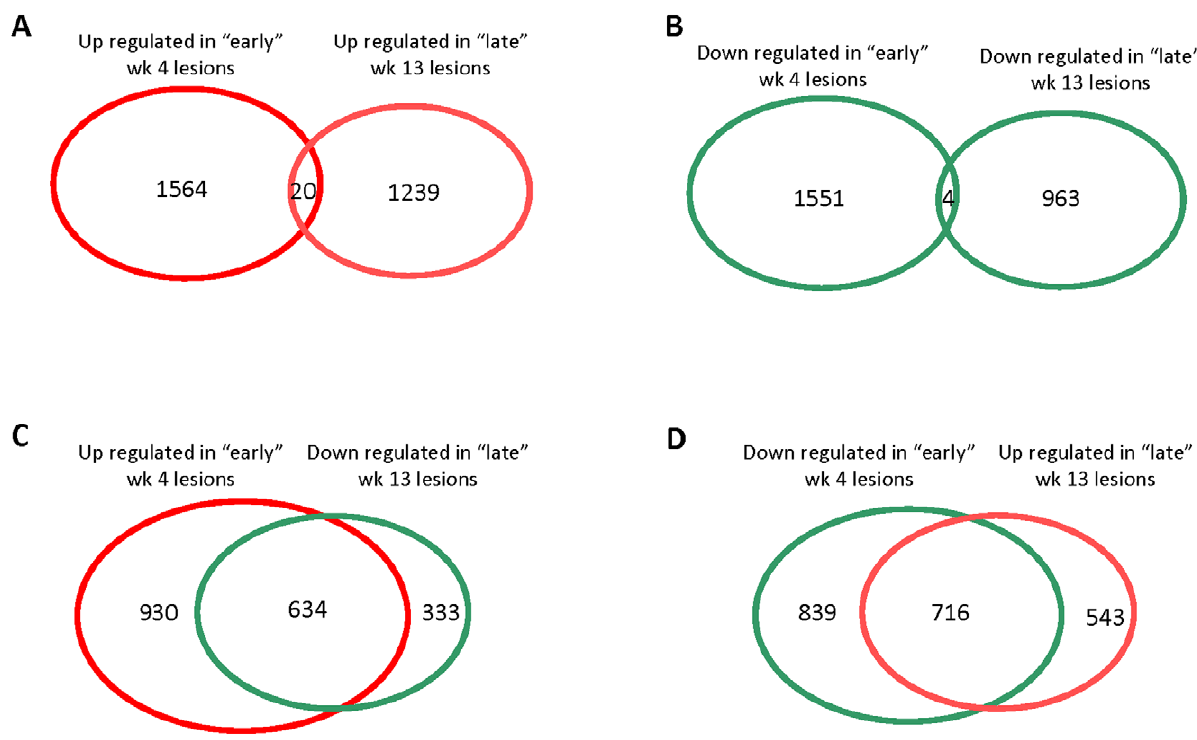
Figure 4. Reprogramming of lesion transcriptome occurs in late, relative to early granulomas. Venn diagrams show the degree of overlap between commonly up regulated (A) and commonly down regulated (B) genes between week 4 and week 13 granuloma lesions. Similarly, overlap is also shown between genes up regulated in week 4 granulomas and down regulated in week 13 granulomas. Genes up regulated in various analyses are represented in red while those down regulated in various analyses are represented in green. The analyses included genes induced or repressed more than 2-fold in a statistically significant manner in all three ‘‘early’’ relative to ‘‘late’’ animals.